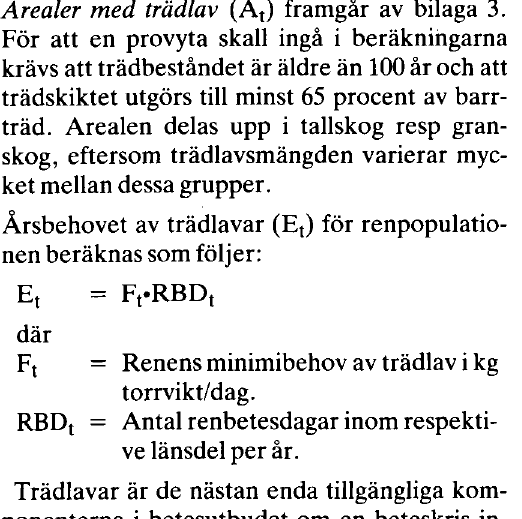
Tabell 2.4. Antal tradlavbetesdagar inom respektive lansdel. Number of days when reindeer graze tree lichens within